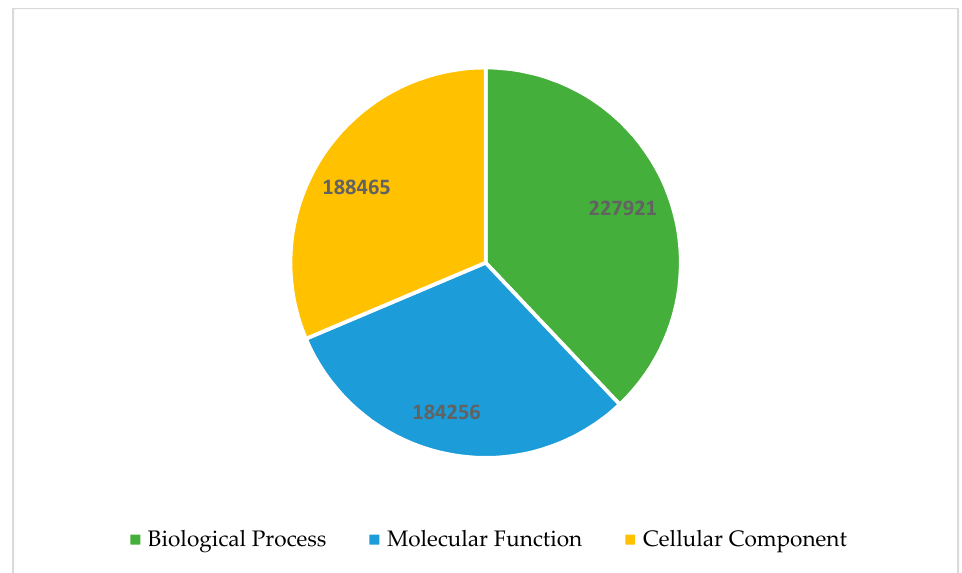
Figure 1. Genes associated with the biological process, cellular components, and molecular functions in the A. marmelos leaf transcriptome assembly.